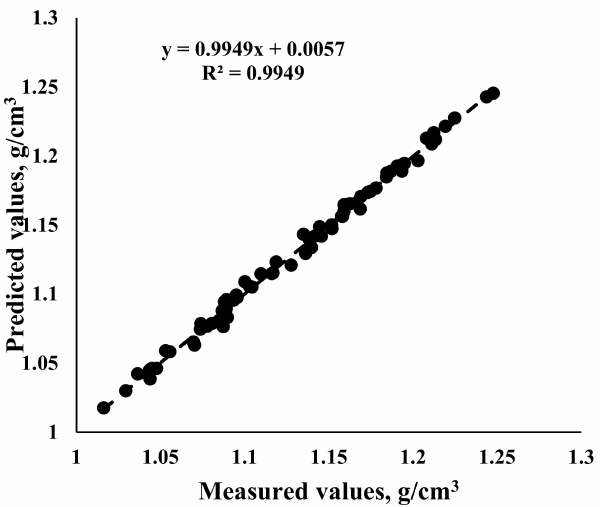
Figure 8. Relationship between measured and predicted values of soil bulk density.